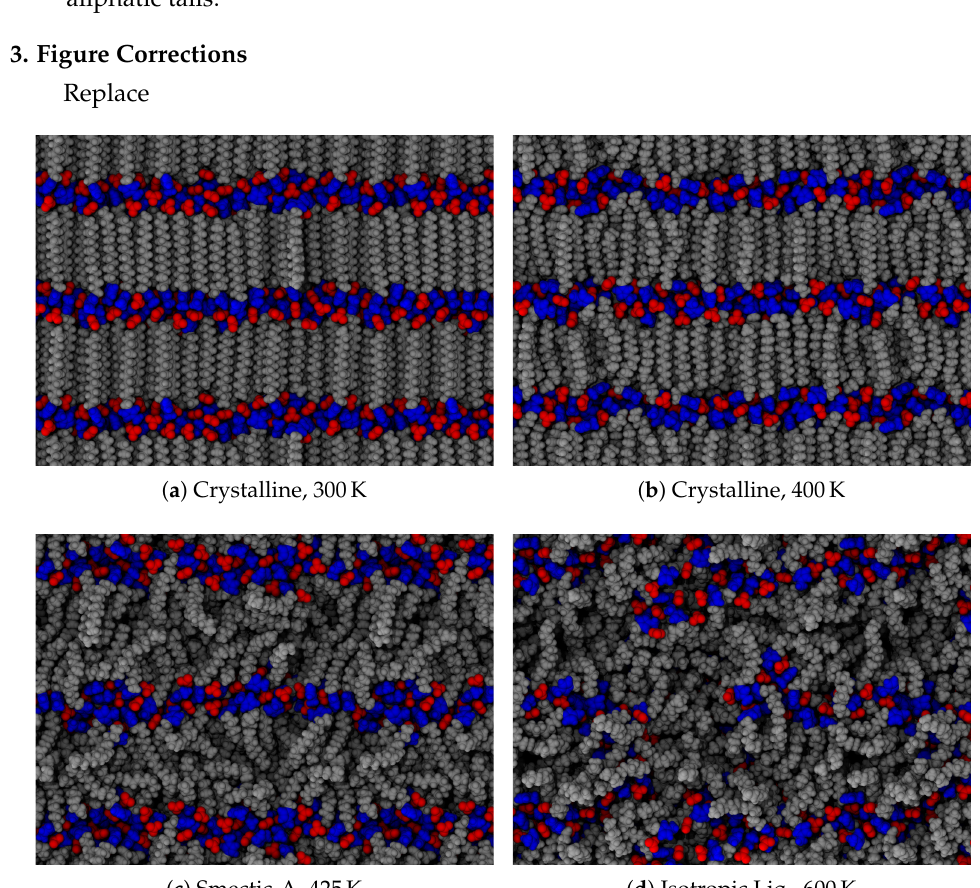
Figure 3. Observed phases in the ionic liquid crystal material, [C 16 MIm][NO 3 ]. Typical configura- tions are presented from temperatures ranging between ( a ) 300K and ( d ) 600K. Frustrations within the crystal are visible in ( a ), as some aliphatic tails are bent within the layer and anions exhibit irregular placement. Intermediate temperatures illustrated in ( b , c ) depict the system on either side of the crystal–smectic phase transition. The isotropic liquid still exhibits segregation, but the layers have lost their long-range order, as evidenced by ( d